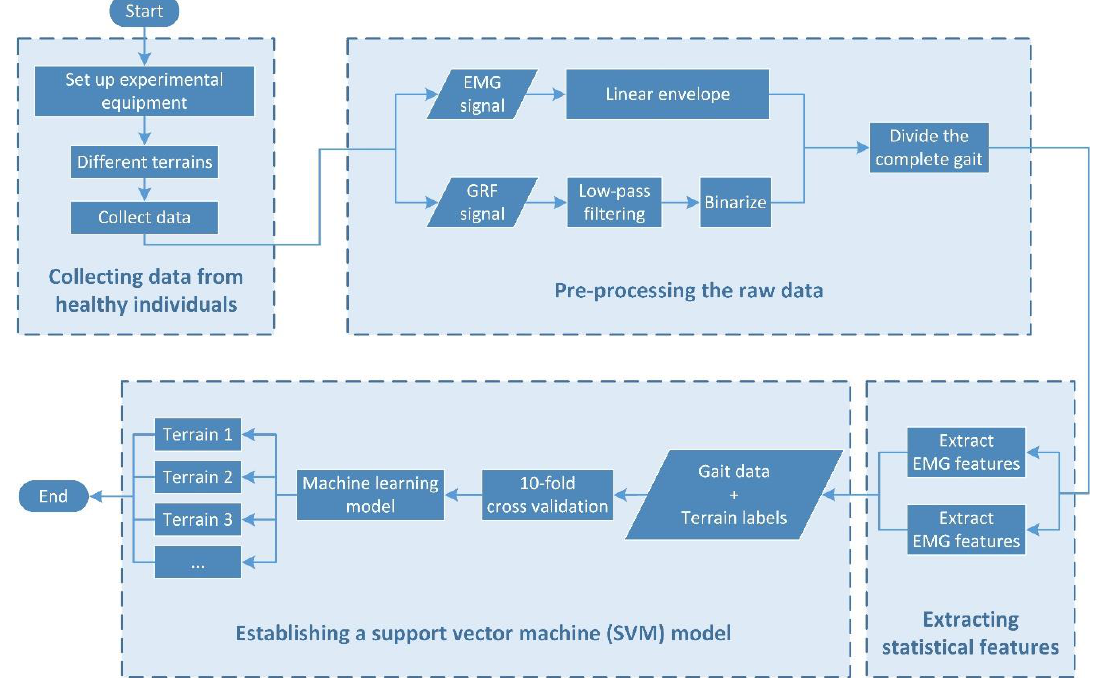
Figure 3. The flowchart of the experiment and data process procedure.